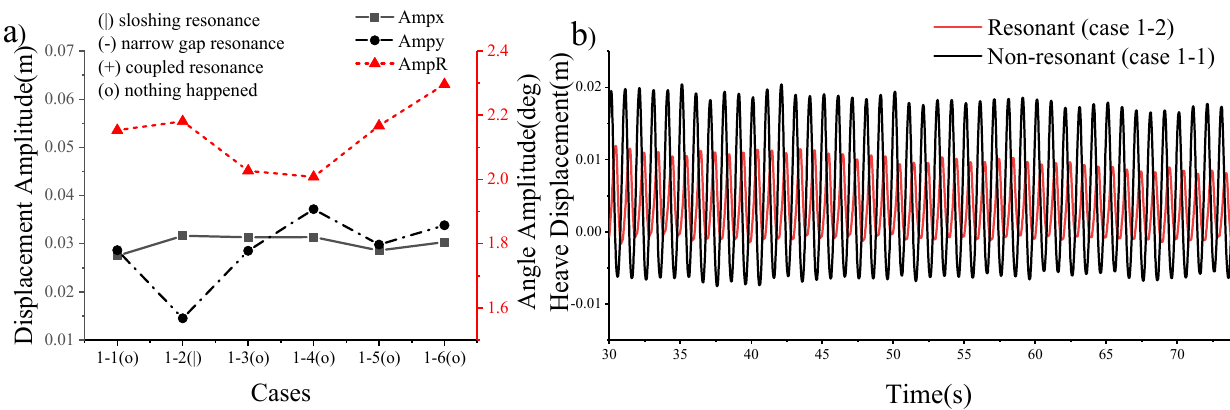
Figure 2. ( a ) Motion response of floating tank in the open sea; ( b ) Time histories of swing motion of floating tank under resonant and non-resonant conditions.